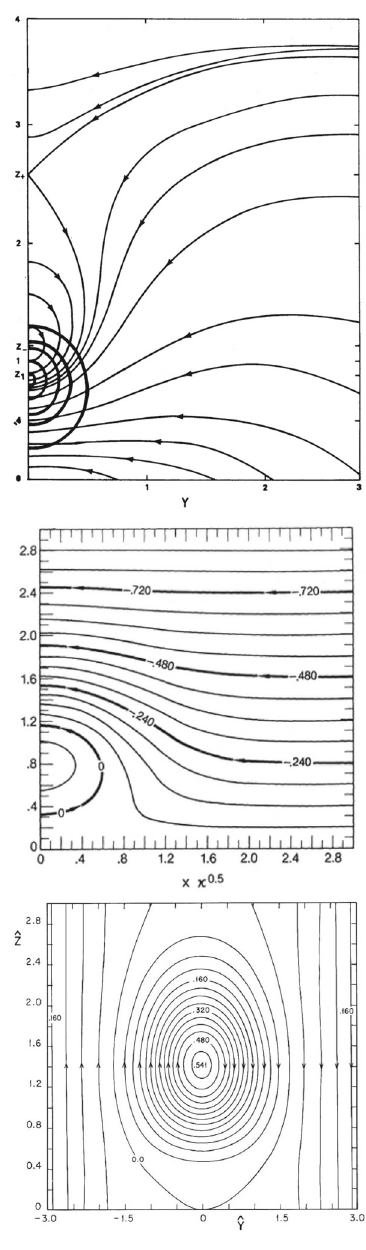
Fig. 42 Magnetic field configuration of the two-dimensional quiescent prominence models whose stability was analysed by Galindo Trejo (1989b,a, 1998, 2006). Top: Low (1981) model, middle: Osherovich (1985) model, bottom: Osherovich (1989) model. These panels do not include all configurations inspected by Galindo Trejo (1989b,a, 1998, 2006). Images reproduced with